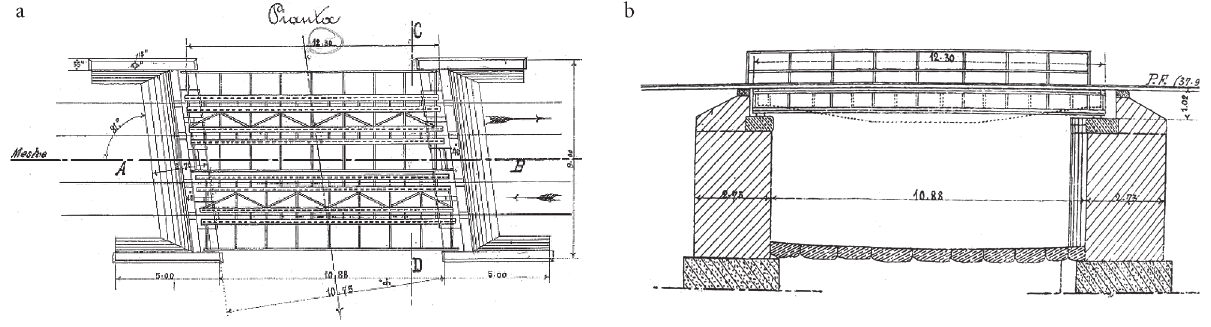
Fig. 1. Original project: a – side view; b – plan, Meschio Bridge, 1918 (Original design, courtesy of